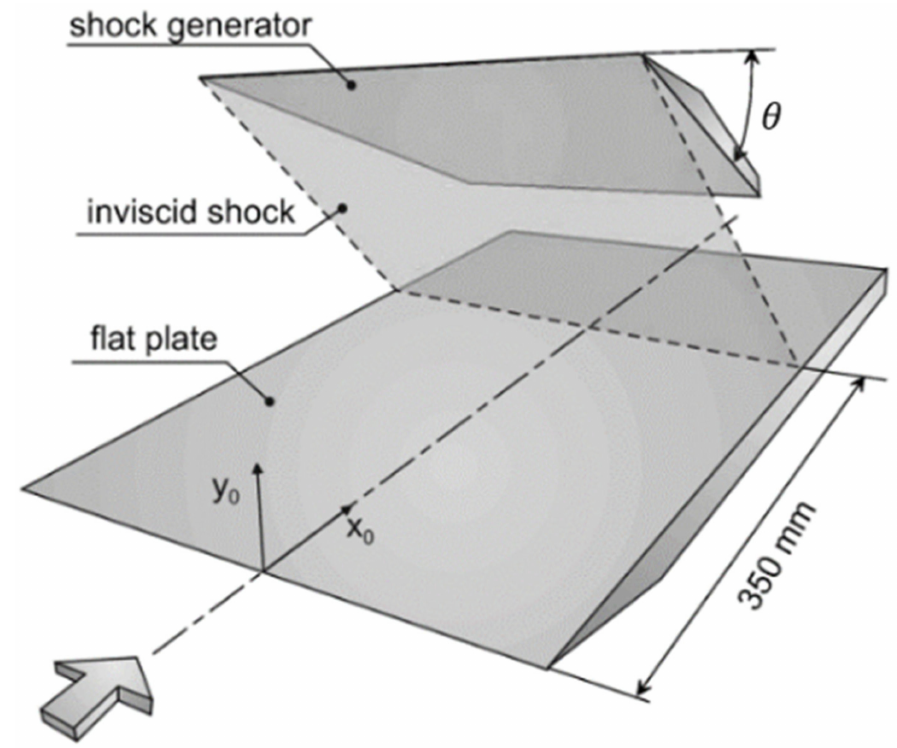
Figure 1. Sketch of the shock generator.